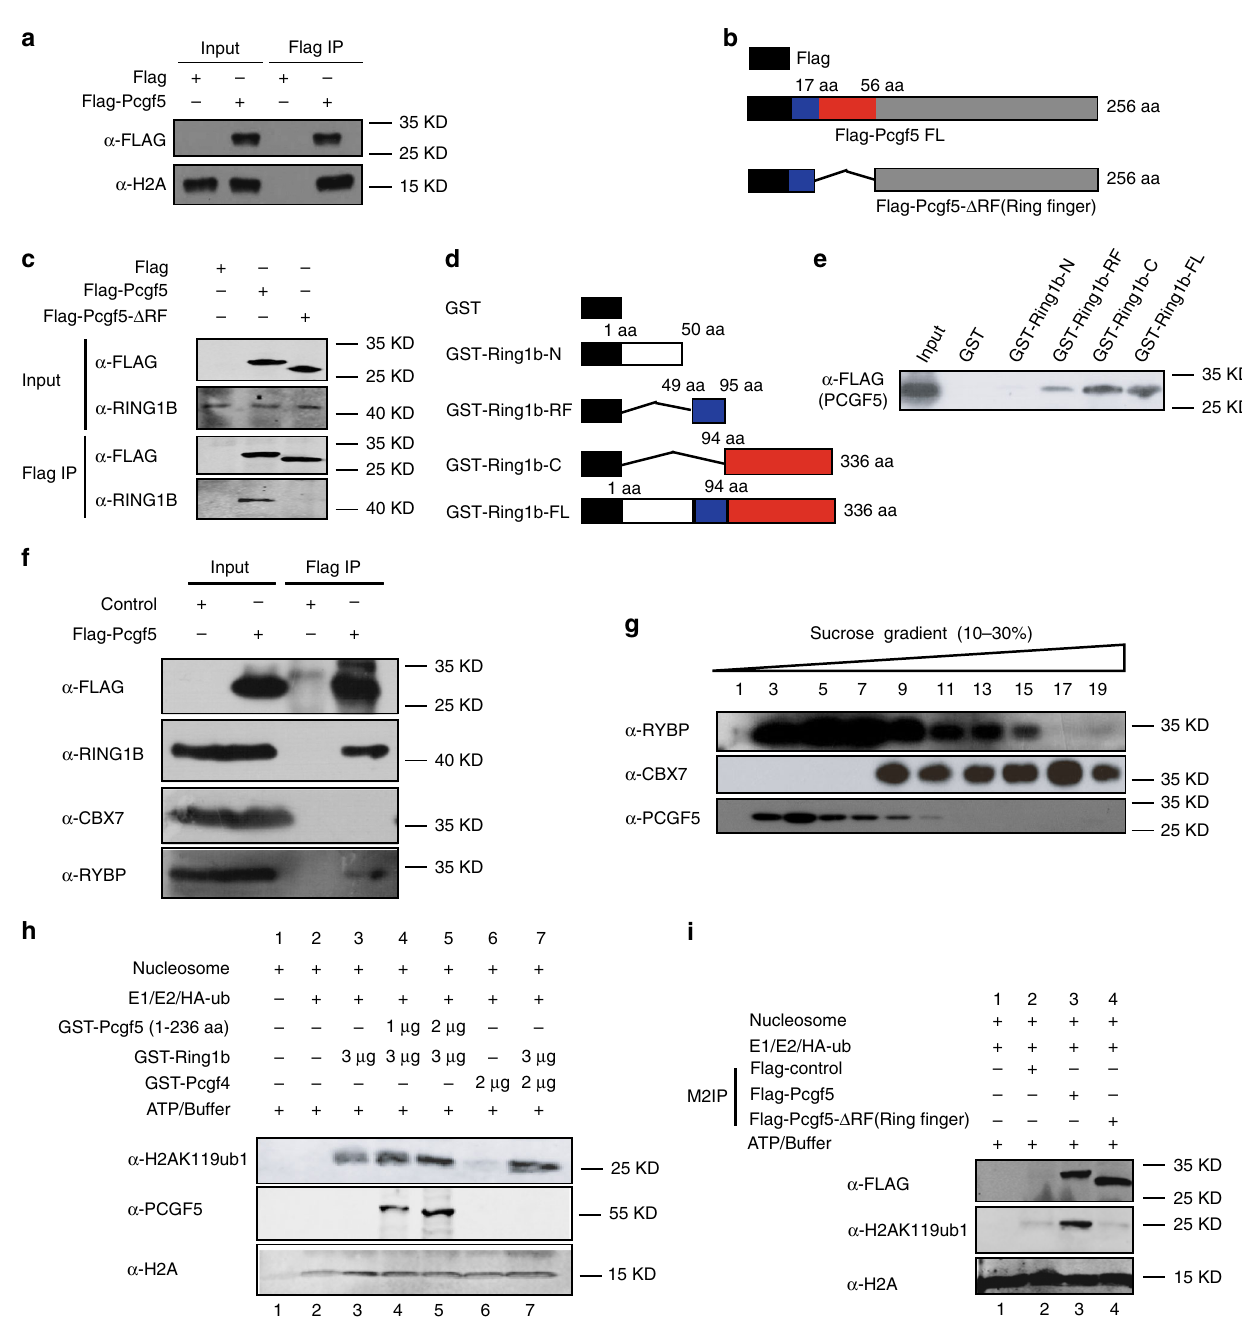
Fig. 3 PCGF5 stimulates RING1B-dependent histone H2AK119ub1. a Detection of the interaction between Flag-PCGF5 and H2A. Flag-tagged empty vector was used as control. b Schematic representation of Flag-PCGF5 and its deletions used in Flag co-IP assays. c Detection of the interaction between RING1B and PCGF5 with or without a Ring- fi nger. d Schematic representation of GST-RING1B and its deletions used in GST pull-down assays. e Proteins probed with anti-FLAG antibody by Western blot. The beads were incubated with cell lysates from the Flag-PCGF5 overexpressed in 293T cells. f Detection of the interaction between Flag-PCGF5 and PRC1 subunits by Flag co-IP in 293T cells. Flag-tagged empty vector was used as a control. g Sucrose gradient analysis of whole cell extracts of mESCs. Every fraction from a 10 – 30% sucrose gradient was further resolved on SDS-PAGE followed by immunoblotting for the indicated antibodies. h In vitro H2A monoubquitinylation assays with nucleosome, GST puri fi ed PCGF5, PCGF4, RING1B, E1, E2 and ubiquitin. The reactions were resolved on SDS – PAGE followed by immunoblotting. i In vitro H2A monoubquitinylation assays with puri fi ed Flag-tagged PCGF5 and Flag-tagged PCGF5 without a Ring- fi nger in 293T cells. The reactions were resolved on SDS-PAGE followed by